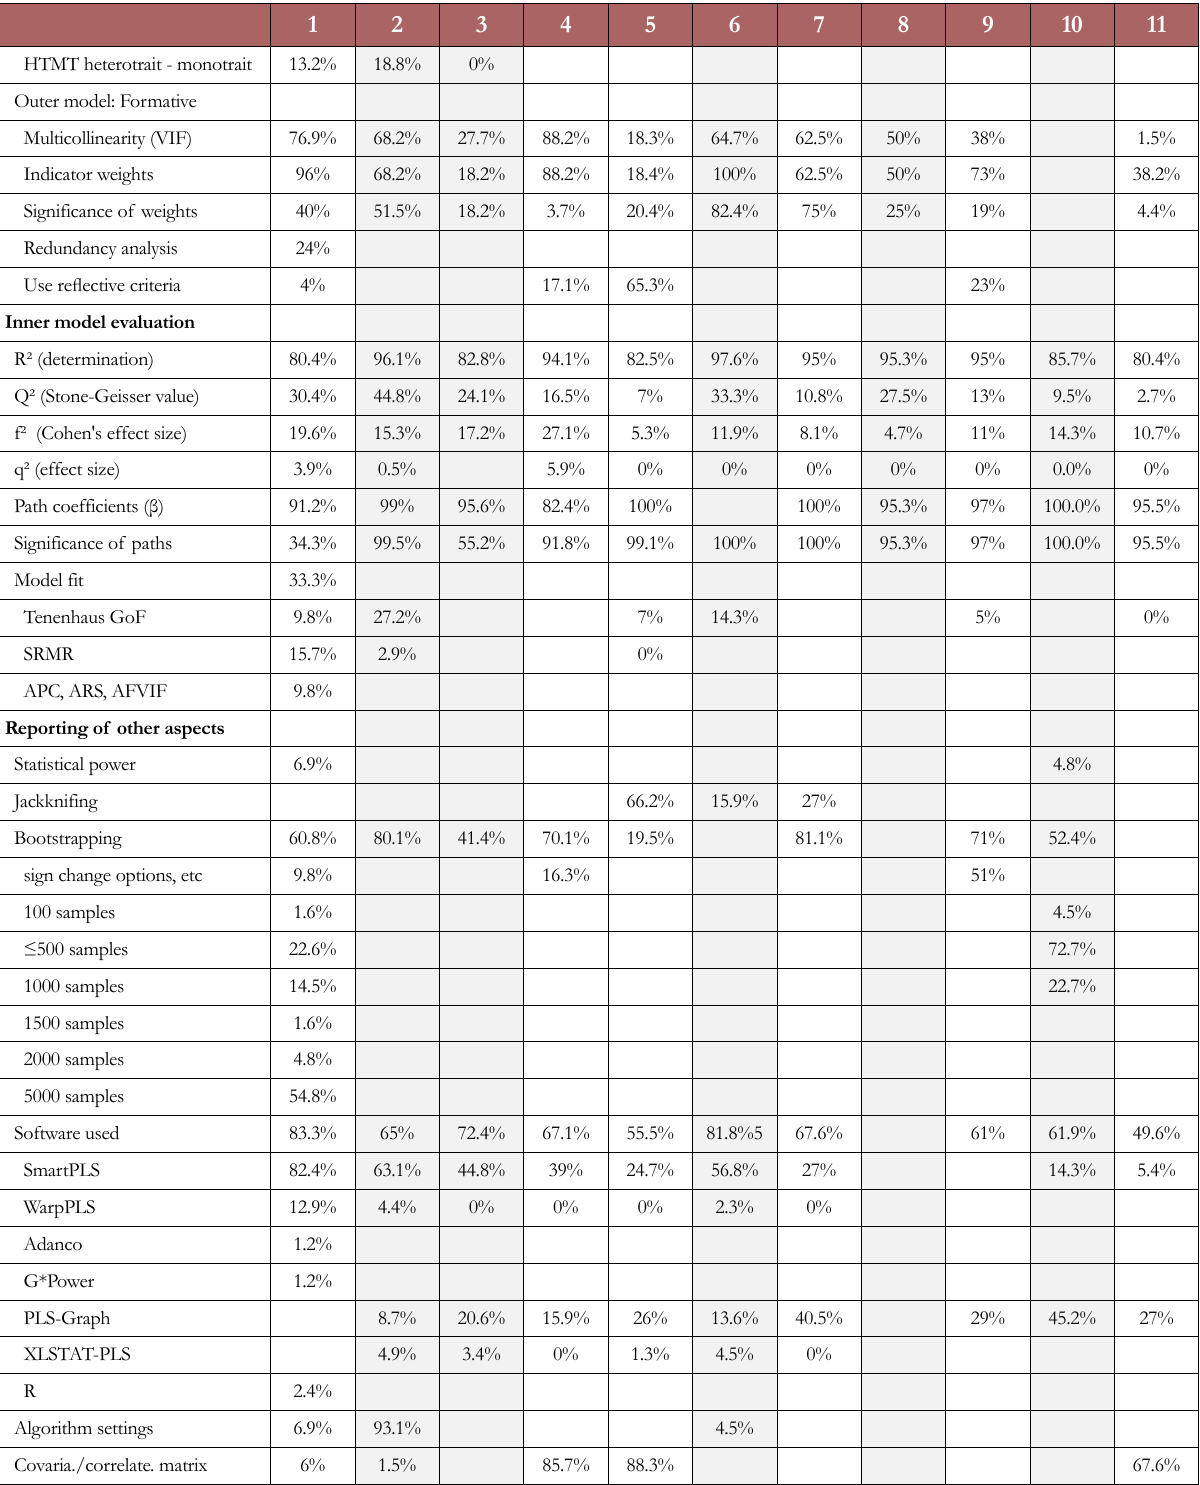
Table 12. Comparison with reviews in other areas. 1: OM Present article; 2: Hosp&Tour (Usakli & Kucukergin,